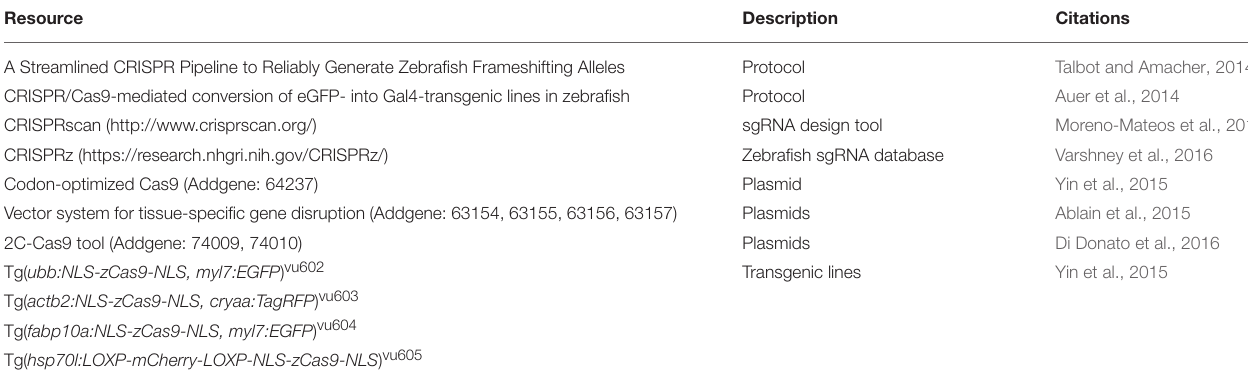
TABLE 1 | Resources for zebrafish CRISPR/Cas9 experimental